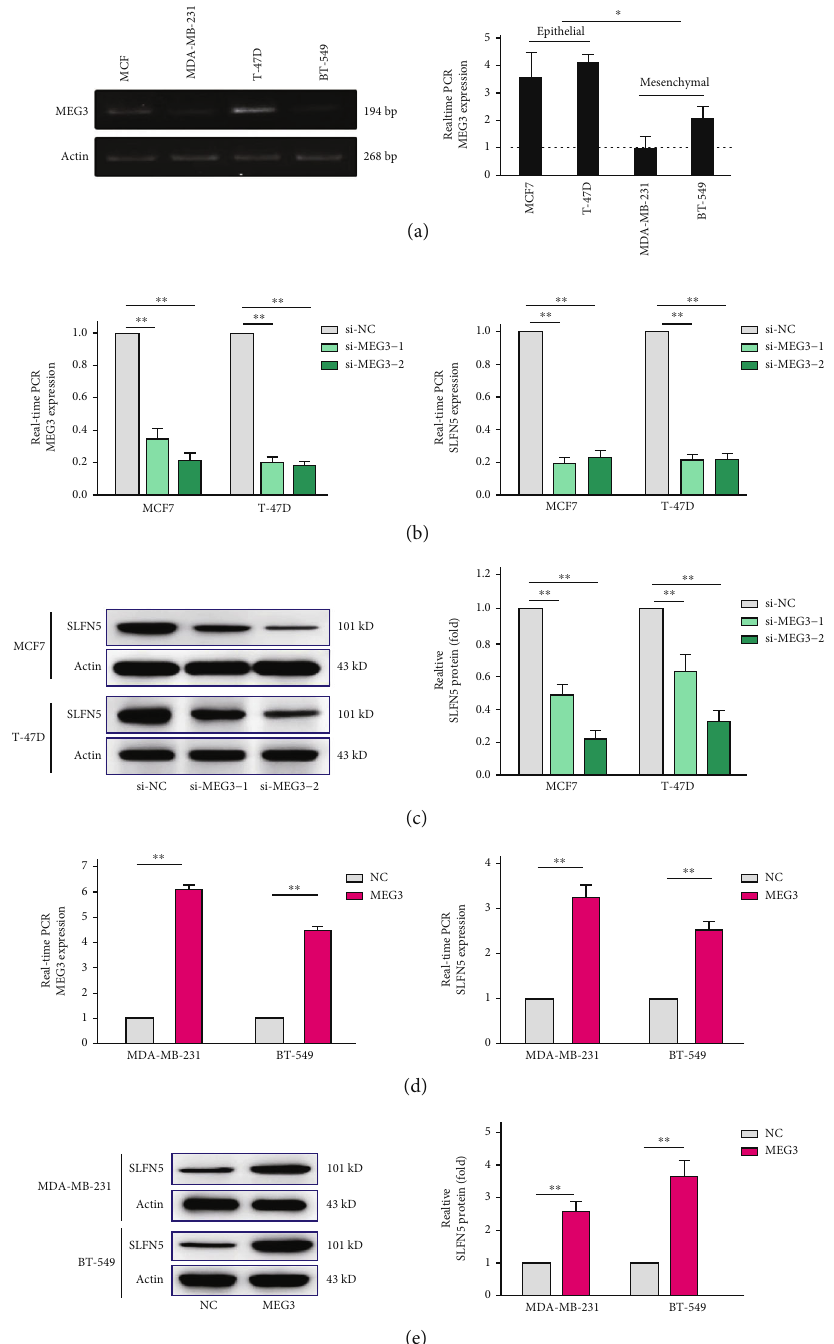
Figure 2: Intervention with MEG3 a ff ects SLFN5 expression in BRCA cells. (a) Real-time PCR analysis of MEG3 RNA level in BRCA cell lines with di ff erent invasive capabilities, high-invasive capability cell lines MDA-MB-231 and BT549, and low-invasive capability cell lines MCF7 and T-47D. (b) Expression change of MEG3 RNA and SLFN5 mRNA in T-47D cells and MCF7 cells interfered with si-MEG3 or negative control siRNA (si-NC) analyzed by real-time PCR. (c) SLFN5 protein change in T-47D cells and MCF7 cells interfered with si- MEG3 or si-NC analyzed by Western blotting. (d) Expression change of MEG3 RNA and SLFN5 mRNA in BT-549 cells and MDA-MB- 231 cells treated with MEG3 plasmids or control plasmids (NC) analyzed by real-time PCR. (e) SLFN5 protein change in BT-549 cells and MDA-MB-231 cells treated with MEG3 or NC plasmids analyzed by Western blotting. ∗∗ P < 0 : 01